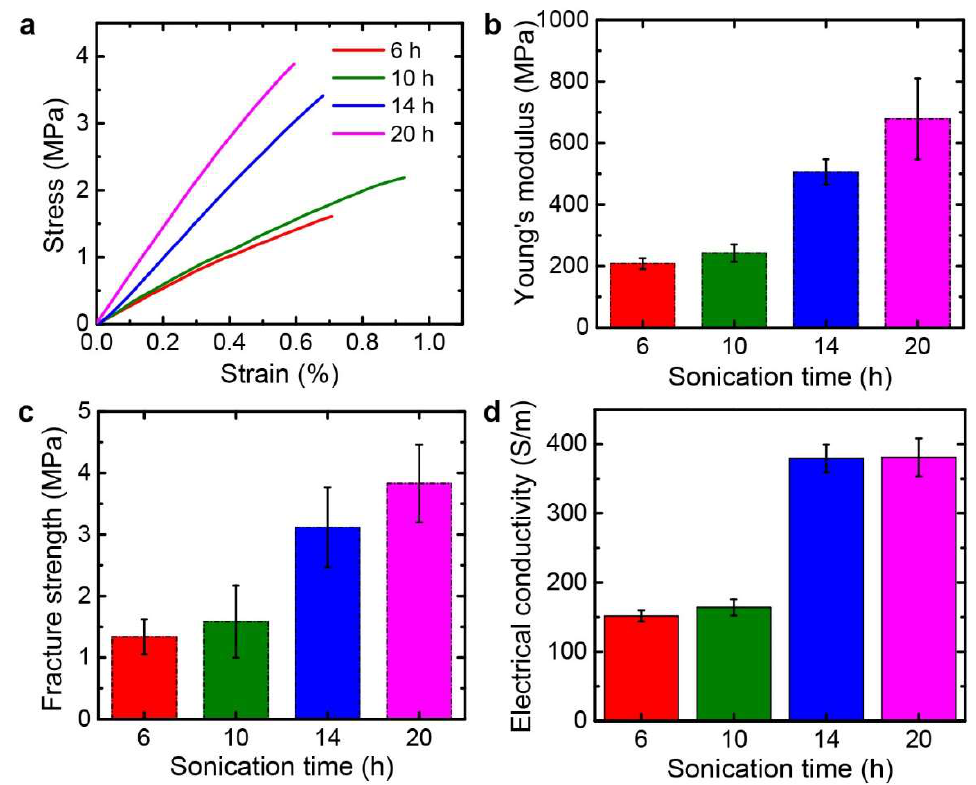
Figure 8. Mechanical and electrical properties of the fabricated rGO papers depending on different sonication times. ( a ) Stress-strain curves. ( b ) Young’s modulus. ( c ) Fracture strength. ( d ) Electrical conductivity.